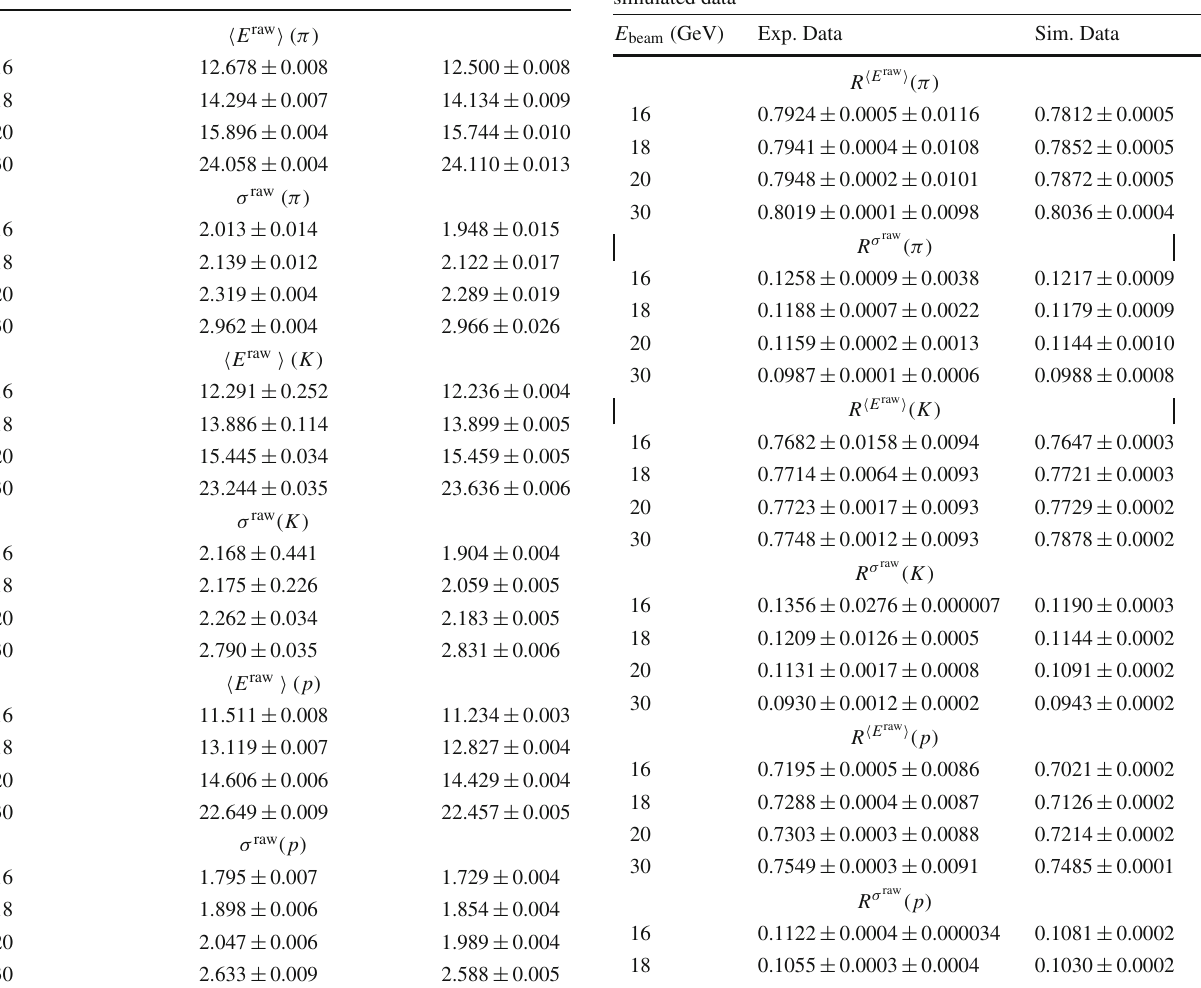
Table6 Energyresponses( R (cid:6) E raw (cid:7) )andresolutions( R σ raw )normalized to incident beam energy obtained using pion ( π ), kaon ( K ) and proton ( p ) data with different beam energies. In the case of experimental data, statistical and systematic uncertainties are reported. The effects of the different systematic uncertainty sources, discussed in Sect. 5.1, were combined in quadrature. Only statistical uncertainties are reported